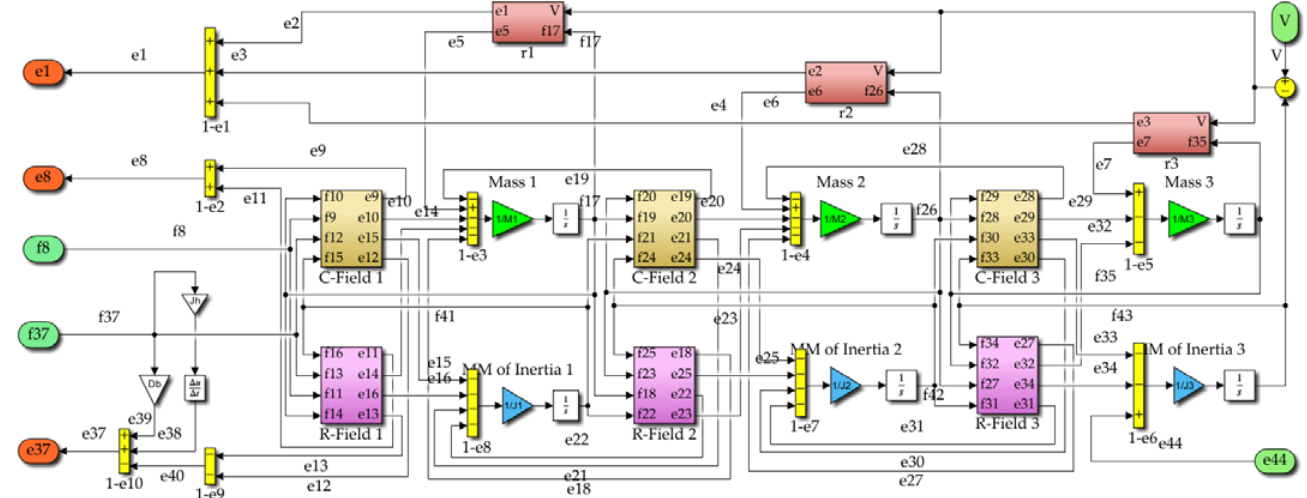
Figure 6. Blade structural model including aerodynamic loads in MATLAB/Simulink.